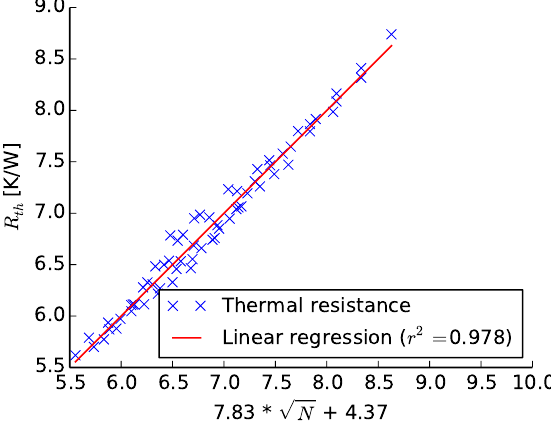
Figure 5. Parity graph for the thermal resistance of the central heat source as a function of the heat source density.